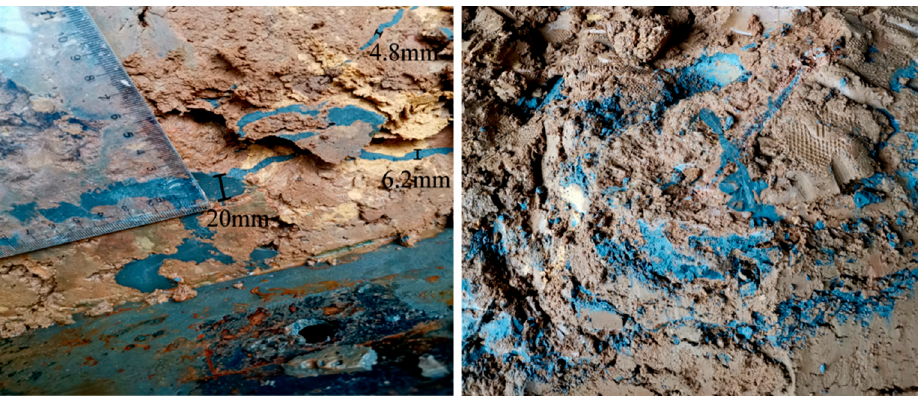
Figure 11. Distribution of branch grouting veins.